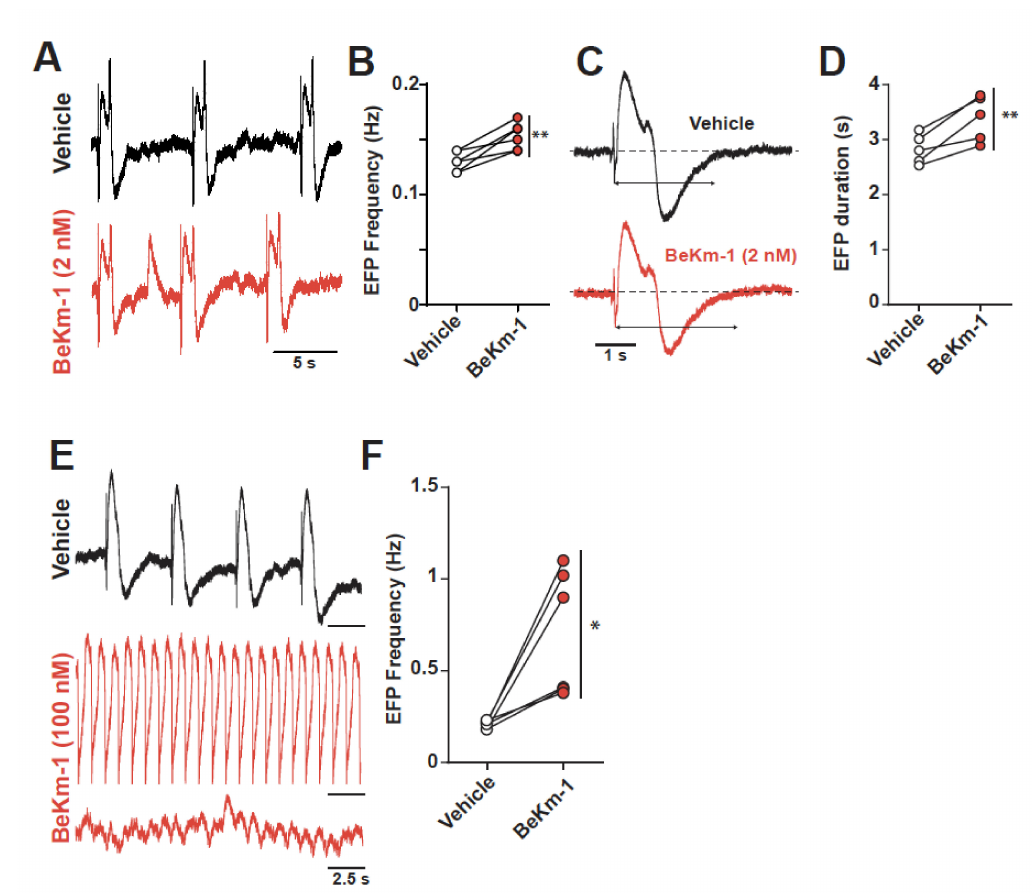
Figure 4. Concentration-dependent impact of BeKm-1 on electric field potential (EFP) properties of a hiPS-CMs monolayer. ( A ) Raw traces of representative EFPs showing a decrease of the frequency following a 2 nM BeKm-1 application. ( B ) Frequency quantification before and after treatment with 2 nM BeKm-1. ( C ) Expanded representative EFP showing prolonged duration following treatment with 2 nM BeKm-1. ( D ) Quantification of EFP duration before and after 2 nM BeKm-1 application. n = 5 independent hiPS-CMs monolayers. Paired t-tests with **, p < 0.01. ( E ) Raw traces of representative EFPs before and after 100 nM BeKm-1 application showing increase in beats frequency and fibrillation-like pattern. ( F ) Quantification of EFP frequency before and after treatment with 100 nM BeKm-1. n = 6 independent hiPS-CMs monolayers (5 sweeps of 30 s for each). Paired t-tests with *, p <